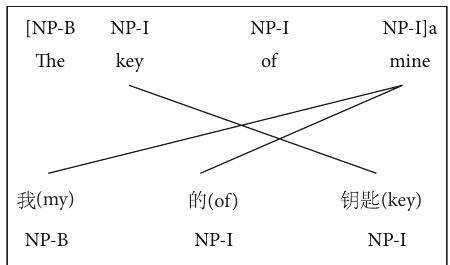
Figure 2: Adjust the Cchunk tag based on position